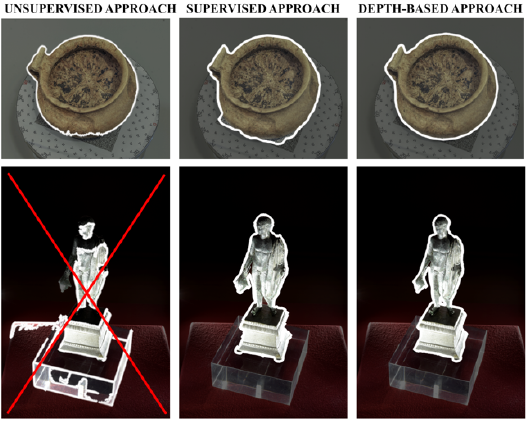
Figure 8. Masking results achieved with different approaches: unsupervised (K-Means Clustering), supervised (Random Forest) and